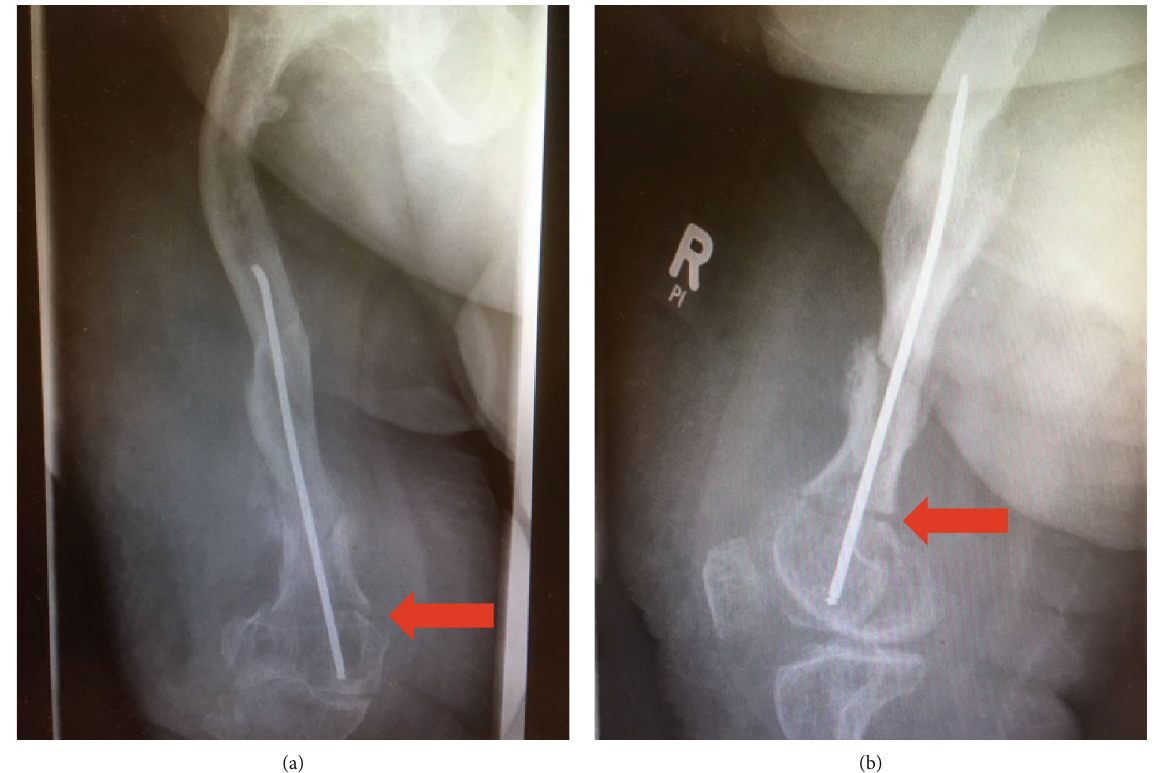
Figure 5: Peri-implant refracture four months after the initial surgery. (a) Anteroposterior view. The red arrow indicated the fracture. It is only minorly dislocated. (b) The corresponding lateral view shows the fracture and the unchanged position of the